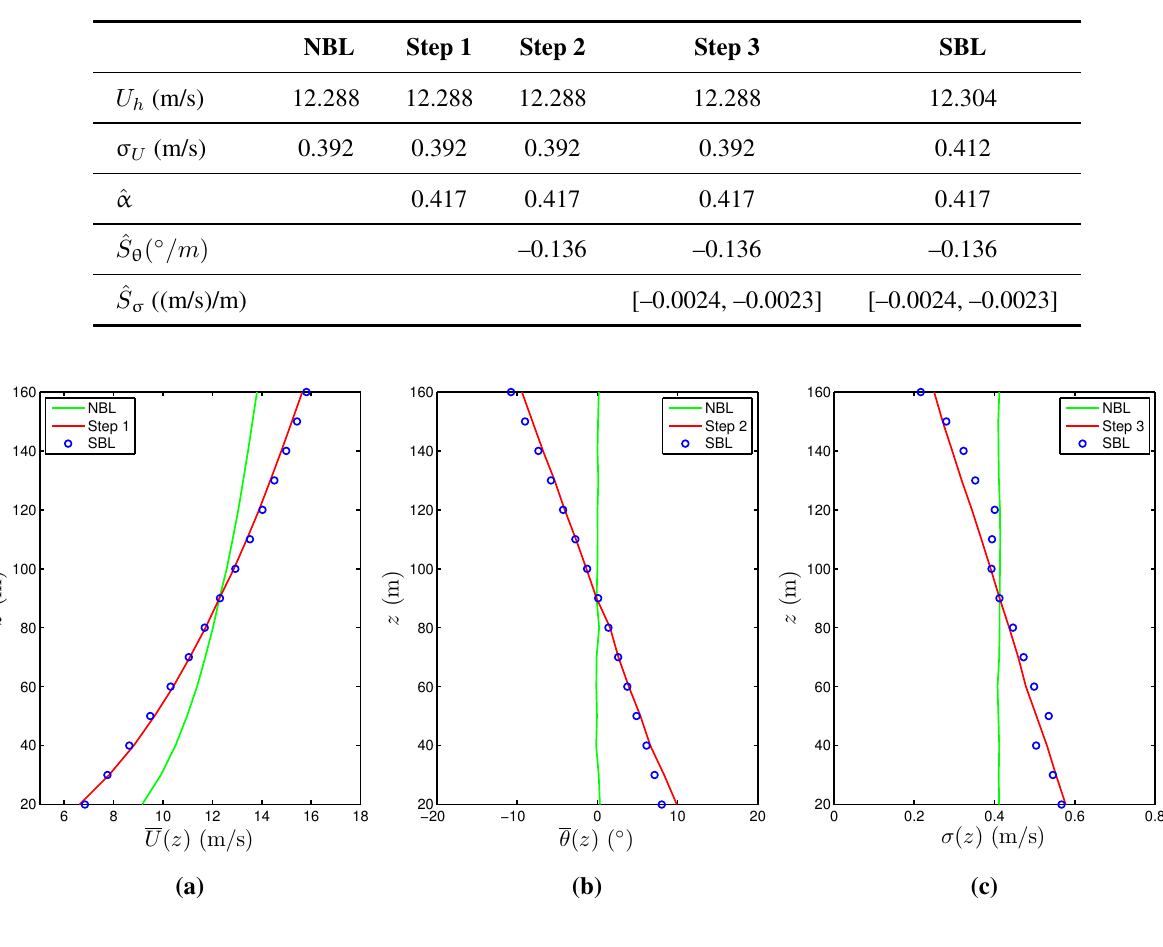
Figure 7. Modification of NBL-based vertical profiles of mean wind speed, mean wind direction, and turbulence standard deviation based on SBL linear fits for a single LES